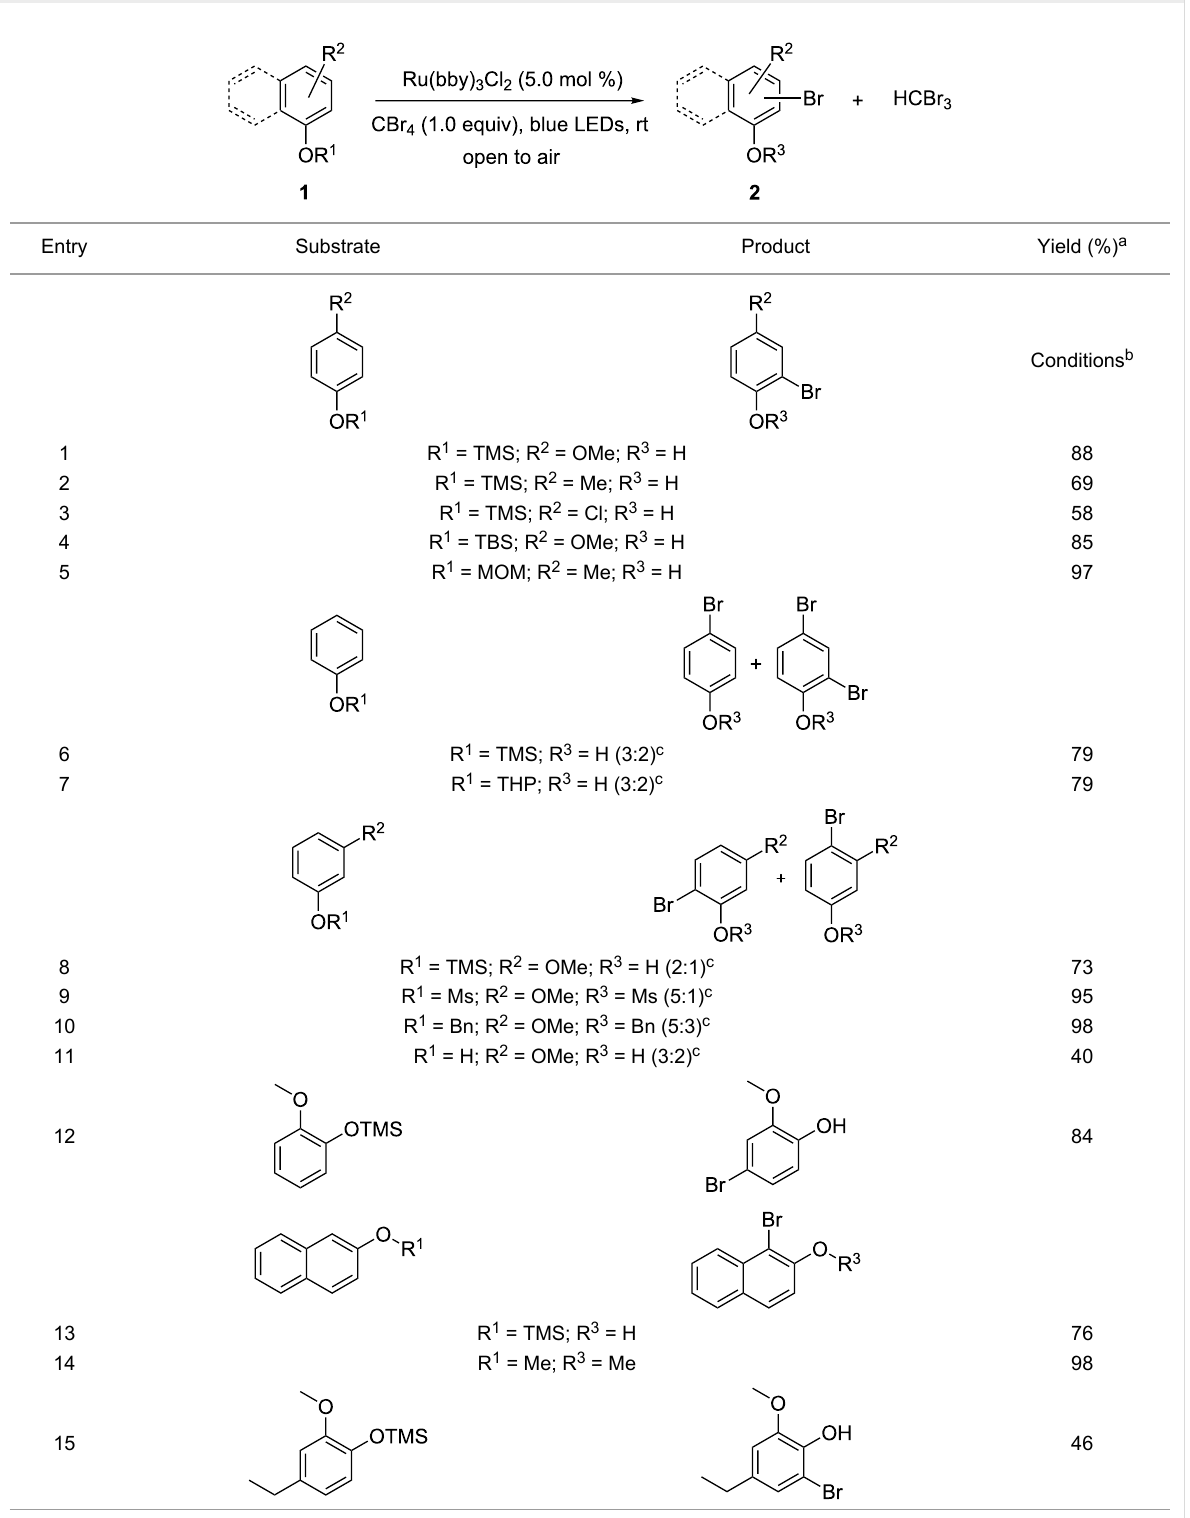
Table 2: Scope of the photocatalytic bromination of